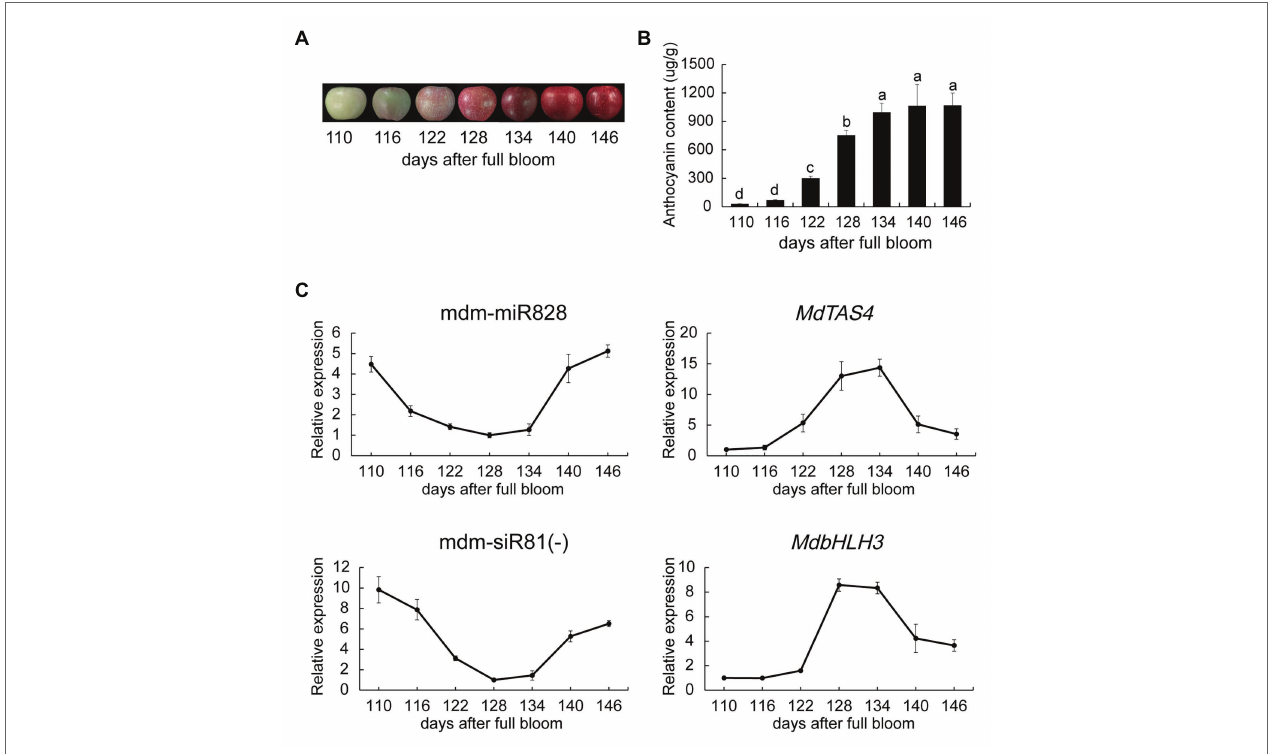
FIGURE 1 | Anthocyanin content and mdm-miR828 expression during coloration of apple “Starkrimson Delicious” fruit. (A) Change in peel color during coloration. (B) Peel anthocyanin content during coloration. (C) Relative expression levels of mdm-miR828, mdm-siR81( − ), and anthocyanin biosynthesis-related genes. The expression levels of mdm-miR828 and mdm-siR81( − ) were detected by the stem-loop method. MdU6 was used as an internal reference. Error bars represent the standard deviation of three biological replicates. Different letters above the bars indicate a significant difference ( p < 0.05; one-way ANOVA and LSD